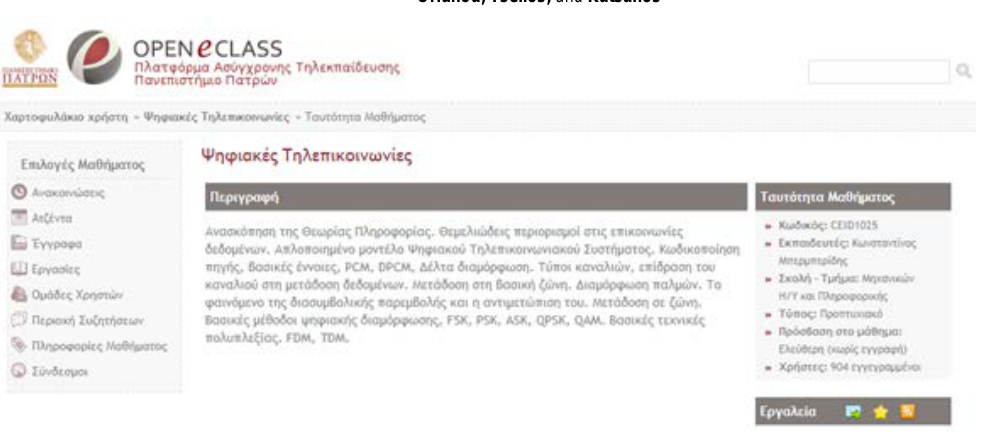
Figure 2. The eClass-based system for the course “Digital Telecommunications” (second